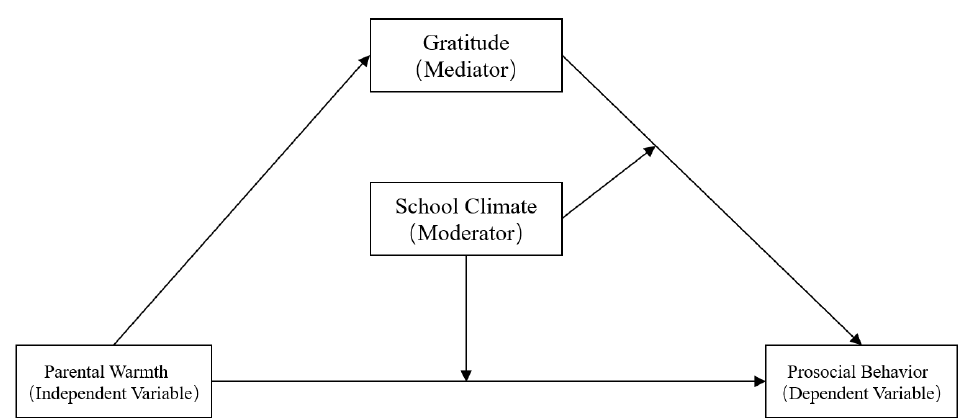
Figure 1. The proposed moderated mediation